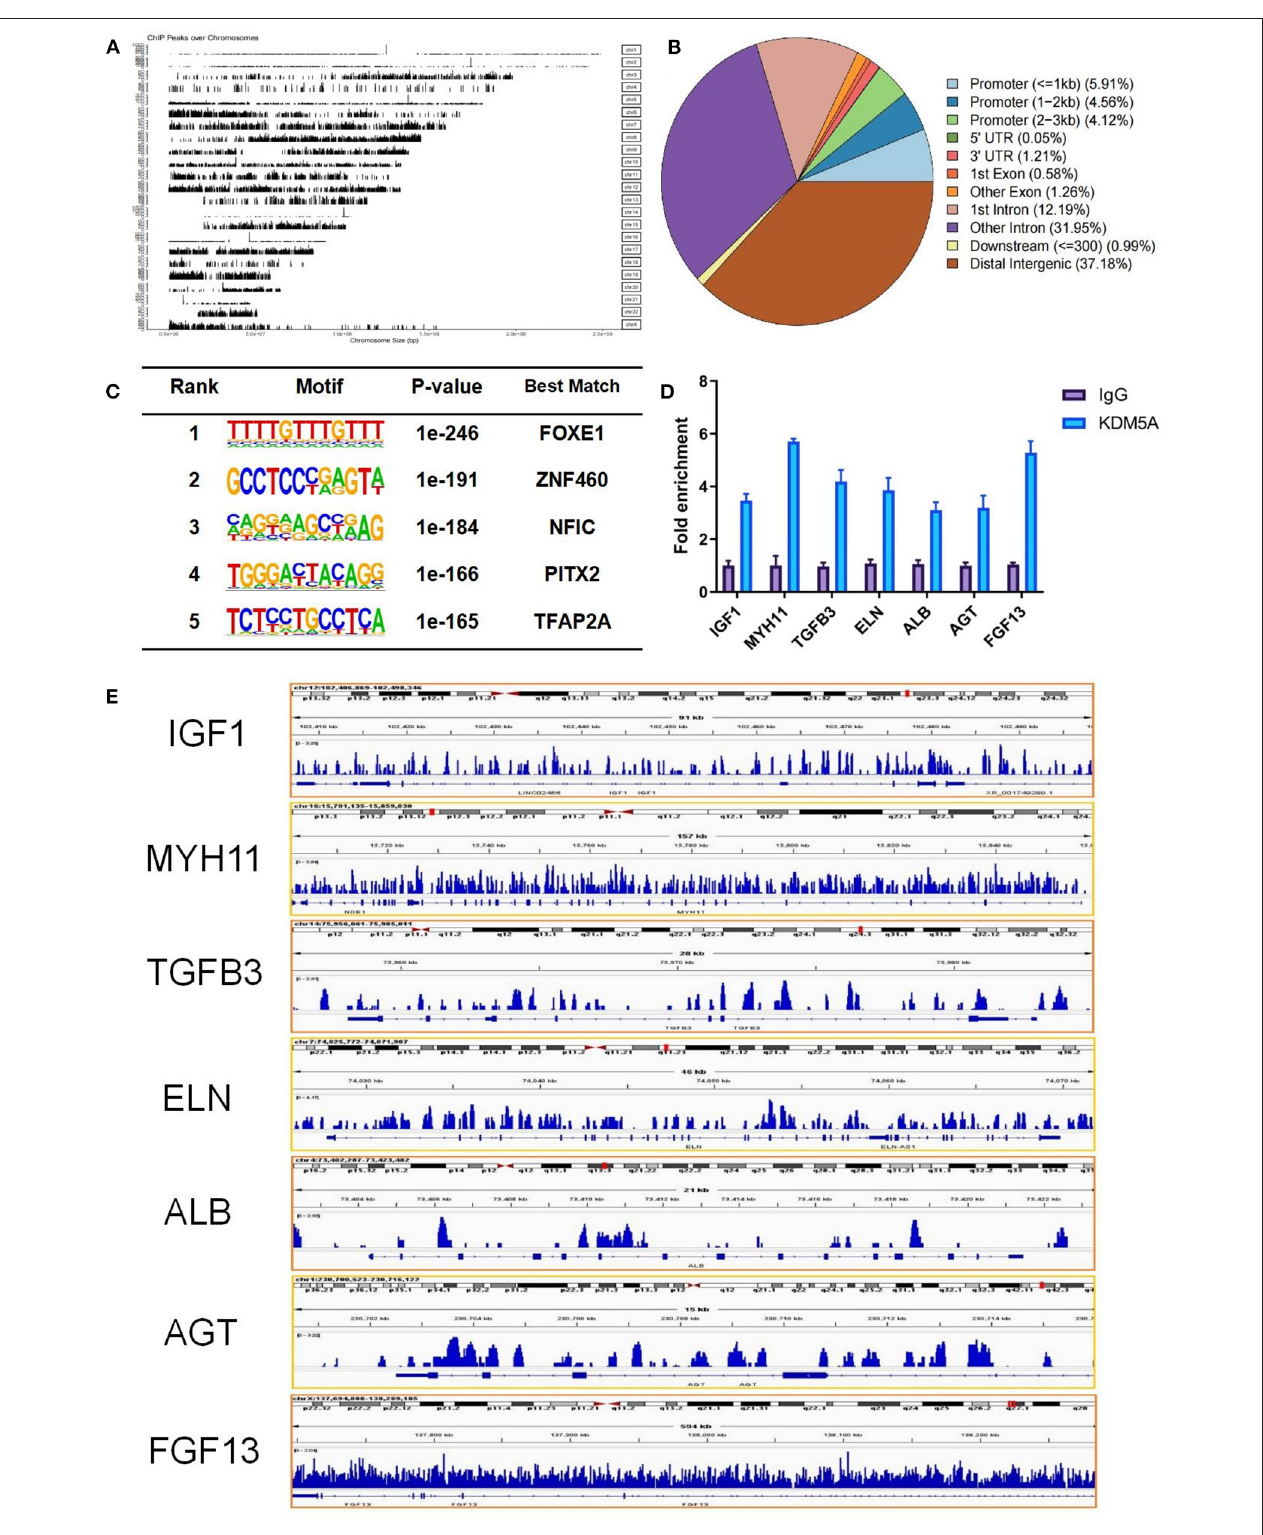
FIGURE 2 | (A) From ChIP-seq, a total of 3.2 × 10 7 reads mapped to the reference genome. (B) The peaks were distributed in the promoter, UTR, exon, intron, downstream, and distal intergenic regions. (C) Characteristic analysis of KDM5A protein binding motif sequence by Homer. (D) IGF1, MYH11, TGFB3, ALB, AGT, FGF13, and ELN enrichment in KDM5A binding sites of the DNA samples in CFs as assessed by ChIP-qPCR. (E) Enriched peaks were identified using the ChIP-seq data via IGV. Each data point was obtained from three replicate experiments.